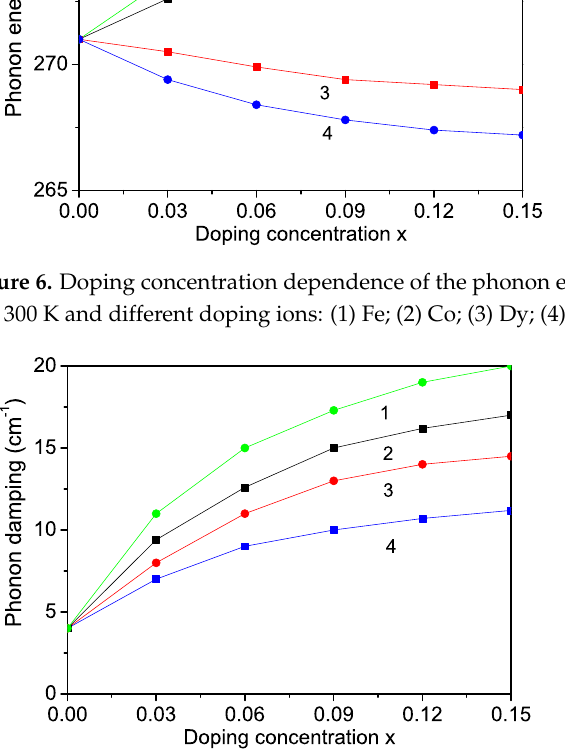
Figure 7. Doping concentration dependence of the phonon damping γ of a ZnS NP for N = 10 shells, T = 300 K and different doping ions: (1) Dy; (2) Nd, (3) Fe; (4) Co. The phonon damping which corresponds to the full width at half maximum of the Raman lines consists of additive contributions from the surface, bulk, spin–phonon